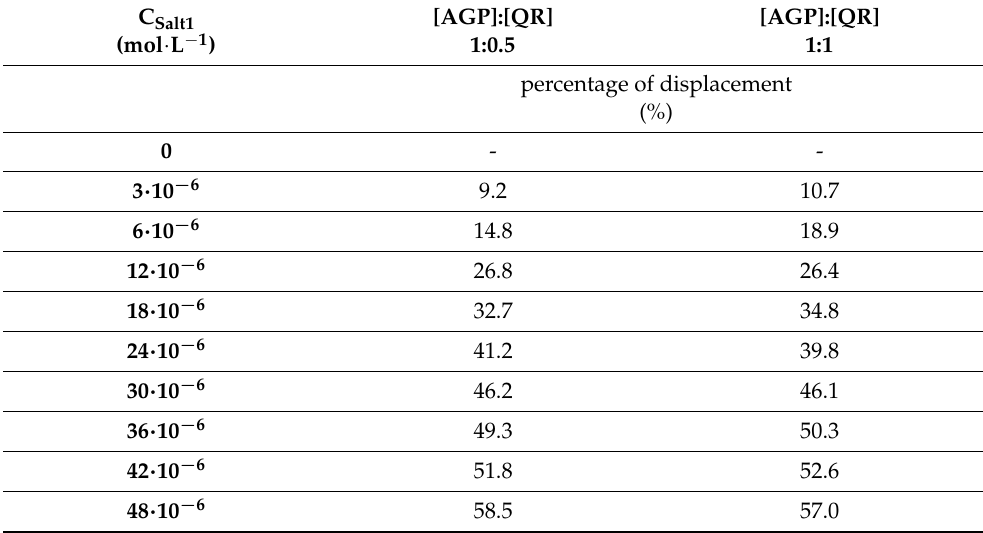
Table 8. The percentage of displacement of QR from the AGP molecule in the presence of